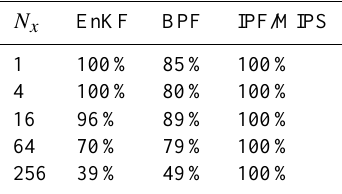
Table 2. Percentage of trials in which an estimate computed with 10 particles is in the same well as the twin solution at the final as- similation time. The well is determined by the sign of the elements of the state vector. Results are computed from 100 trials each with at least one transition.